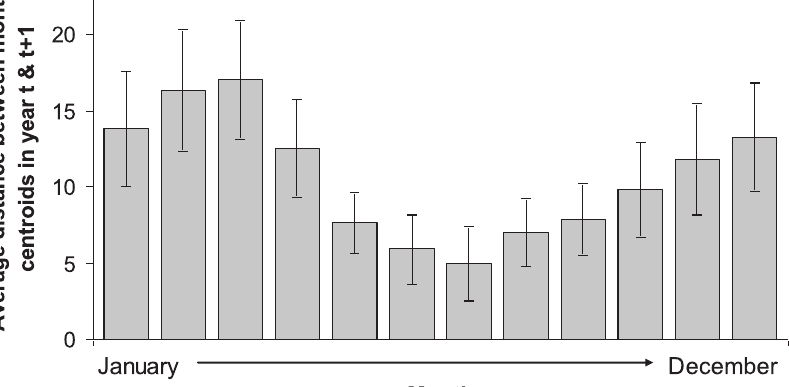
Fig. 4. Monthly range fidelity as assessed by measuring the average distance (km) between monthly centroids of caribou observed in year t and year t+1 . The cen- troid of each monthly location was calculated by taking the harmonic mean of 2 to 8 observations per month per caribou. Between 1992 and 2000, we recorded 1359 months where the same caribou ( n =45) was located between consecutive years. Er- ror bars represent 95% confidence